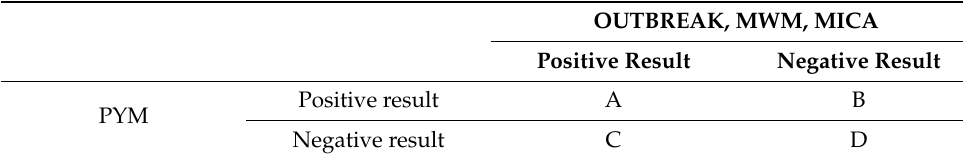
Table 2. The generalized example of contingency